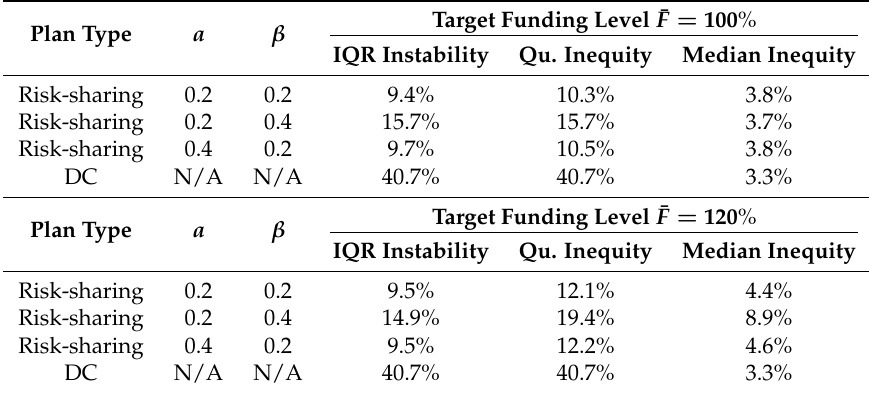
Table 2. Instability and inequity, across the generations for different target funding